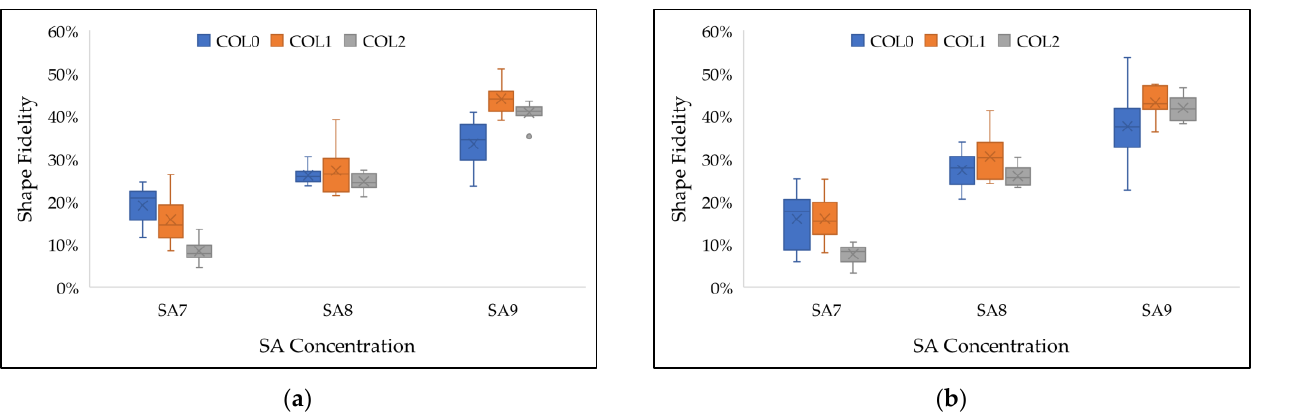
Figure 8. Boxplot of the percentage of measurement mesh area compared to designed 3D model ( a ) before crosslinking, and ( b ) after crosslinking.